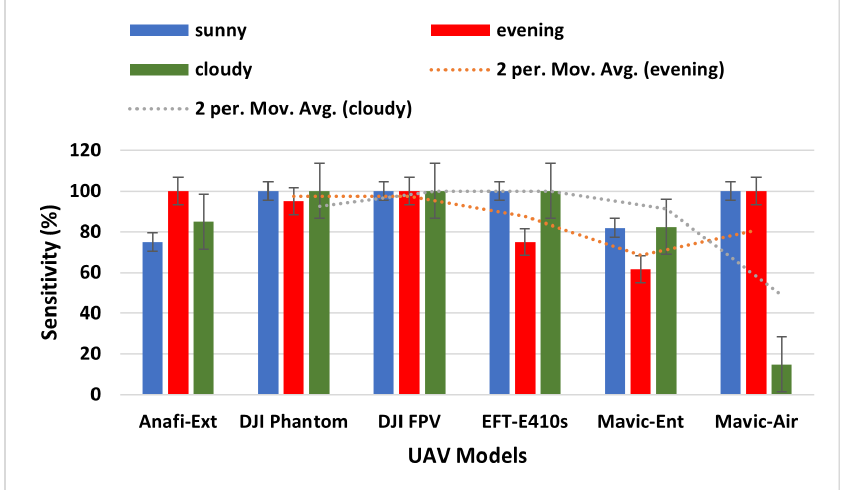
Figure 9. Sensitivity graph of ALIEN performance for detecting UAV models across all scenarios.